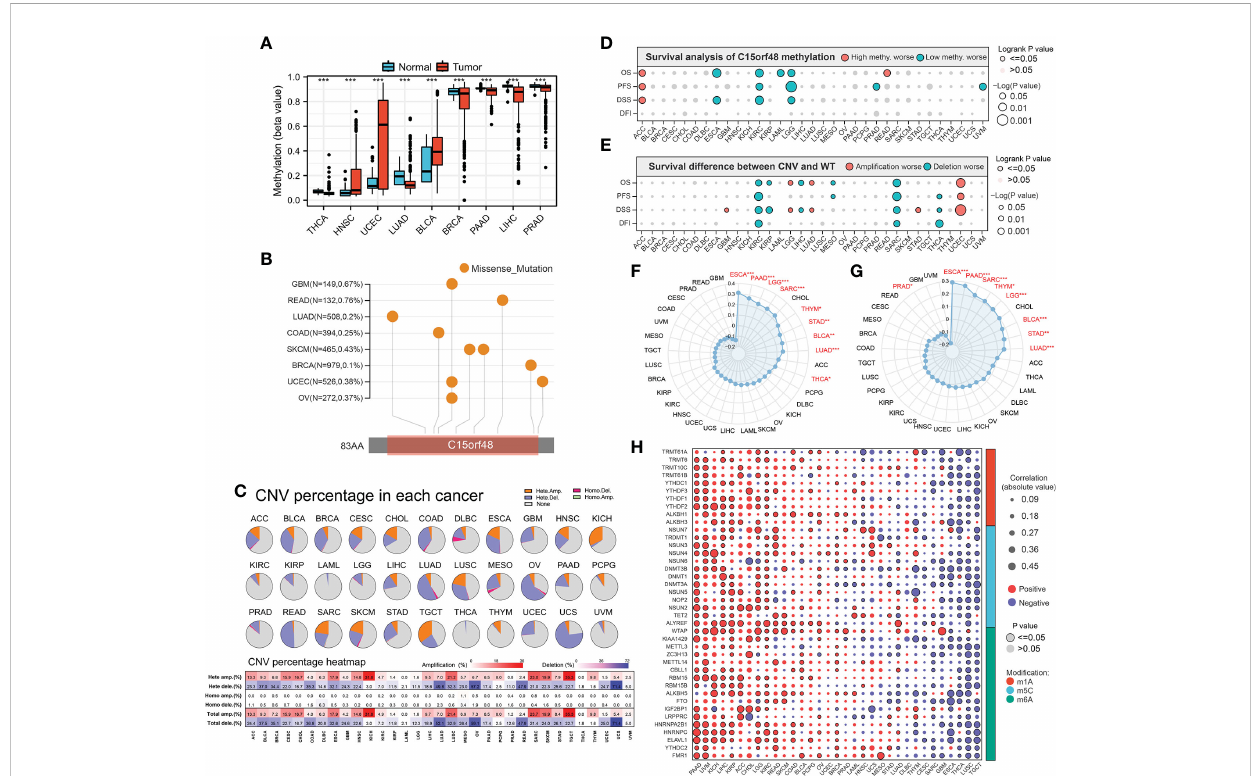
FIGURE 3 (A) Differential methylation levels of C15orf48 in normal and tumor tissues in pan-cancer; (B) Somatic mutation levels of C15orf48 in pan-cancer; (C) Copy number variation levels of C15orf48 in pan-cancer; (D) The relationship between methylation of C15orf48 and prognosis in pan-cancer; (E) The relationship between copy number variation of C15orf48 and prognosis in pan-cancer; (F) Relationship between C15orf48 and tumor mutational burden in pan-cancer; (G) Relationship between C15orf48 and microsatellite instability in pan-cancer; (H) Correlation between C15orf48 and RNA-modifying genes in pan-cancer. *p < 0.05; **p < 0.01; ***p < 0.001.